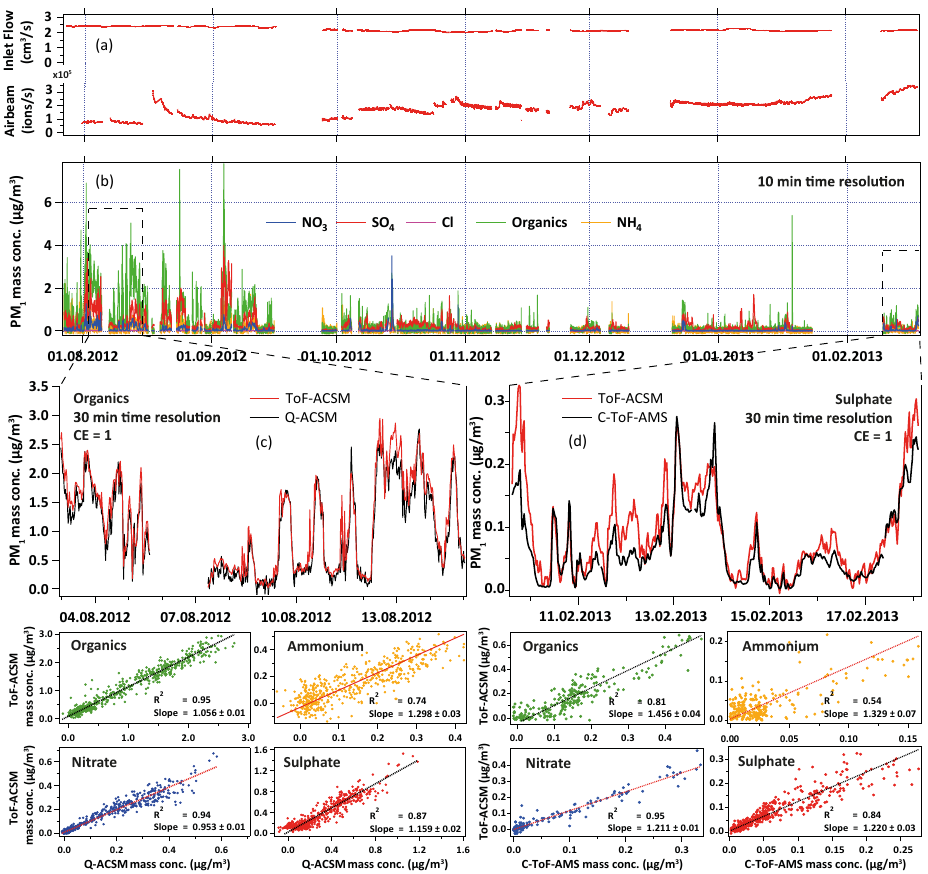
Fig. 7. Long-term time series and correlation of the ToF-ACSM to a Q-ACSM and a C-ToF-AMS. The two time series on the top show inlet pressure and airbeam variation during the ∼ 6months measurement period. These two parameters are used to correct for changes in the inlet flow or detector gain. Below the time series of the organics (green), SO 4 (red), NO 3 (blue), NH 4 (orange) and chloride (pink) measured on the Jungfraujoch with a time resolution of 10min are depicted. The periods 3–15 August 2012 and 9–18 February were enlarged to illustrate the correlation of the ToF-ACSM to Q-ACSM (left) and C-ToF-AMS (right). In each case the time trace of the organics measured with the two instruments (30min time resolution) are shown together with the scatter plots of the other species. Coefficient of determination and slope in the comparison of the two ACSM are as follows: R 2 = 0 . 95, slope=1.056 (organics), R 2 = 0 . 87, slope=1.159 (SO 4 ), (NO 3 ) R 2 = 0 . 94, slope=0.953, (NH 4 ) R 2 = 0 . 74, slope=1.298. In the comparison to the C-ToF-AMS they are as follows: R 2 = 0 . 81, slope=1.456 (organics), R 2 = 0 . 84, slope=1.220 (SO 4 ), R 2 = 0 . 95, slope=1.211 (NO 3 ), R 2 = 0 . 54, slope=1.329 (NH 4 ). Note the difference in the scale (dynamic range) between the comparison to the Q-ACSM in summer and the comparison to the C-ToF-AMS in